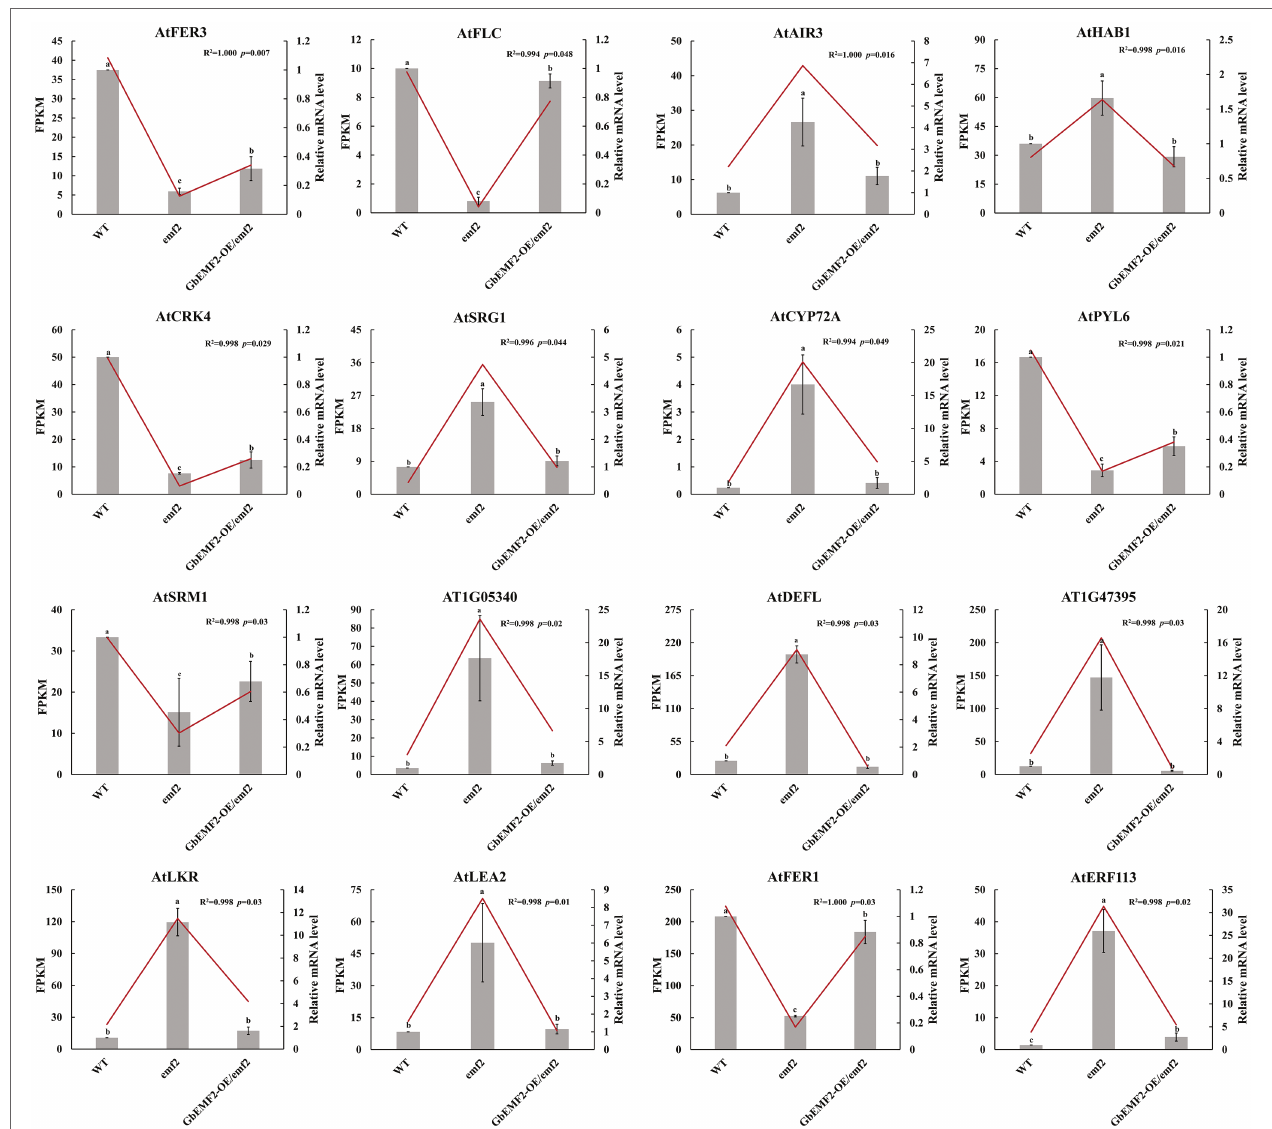
FIGURE 8 | The qRT-PCR validation of the expression patterns of 16 DEGs. Data are mean ± SD of three biological replicates with 10 plants per replicate. Line and block represent RNA-seq and qRT-PCR data. Letters mean significant difference at p ≤ 0.05 by the Duncan’s multiple range